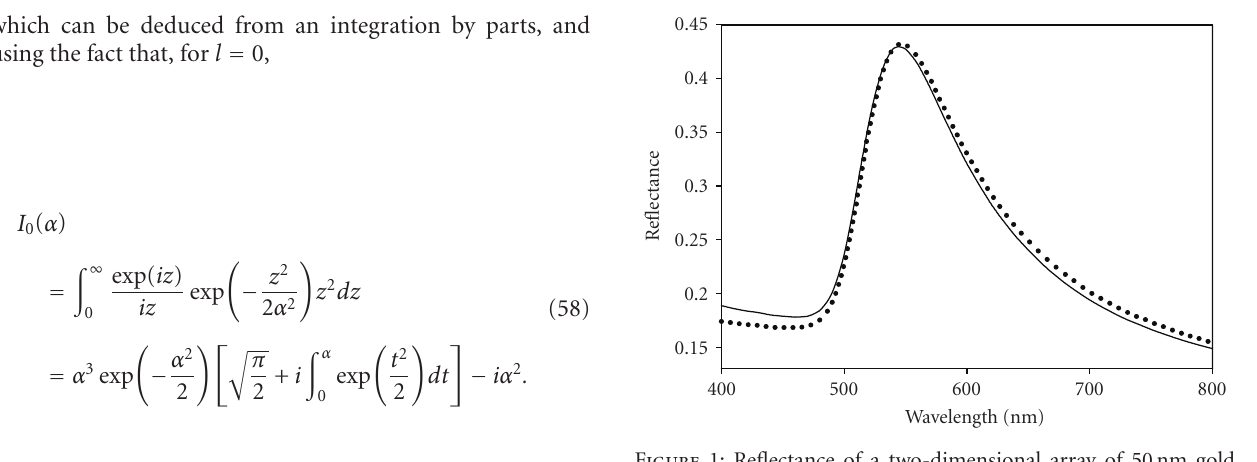
Figure 1: Reflectance of a two-dimensional array of 50nm gold nanoparticles deposited on glass separated by an interparticle distance of 60 nm. Solid line: dipolar approximation, dotted line: multipolar calculations.